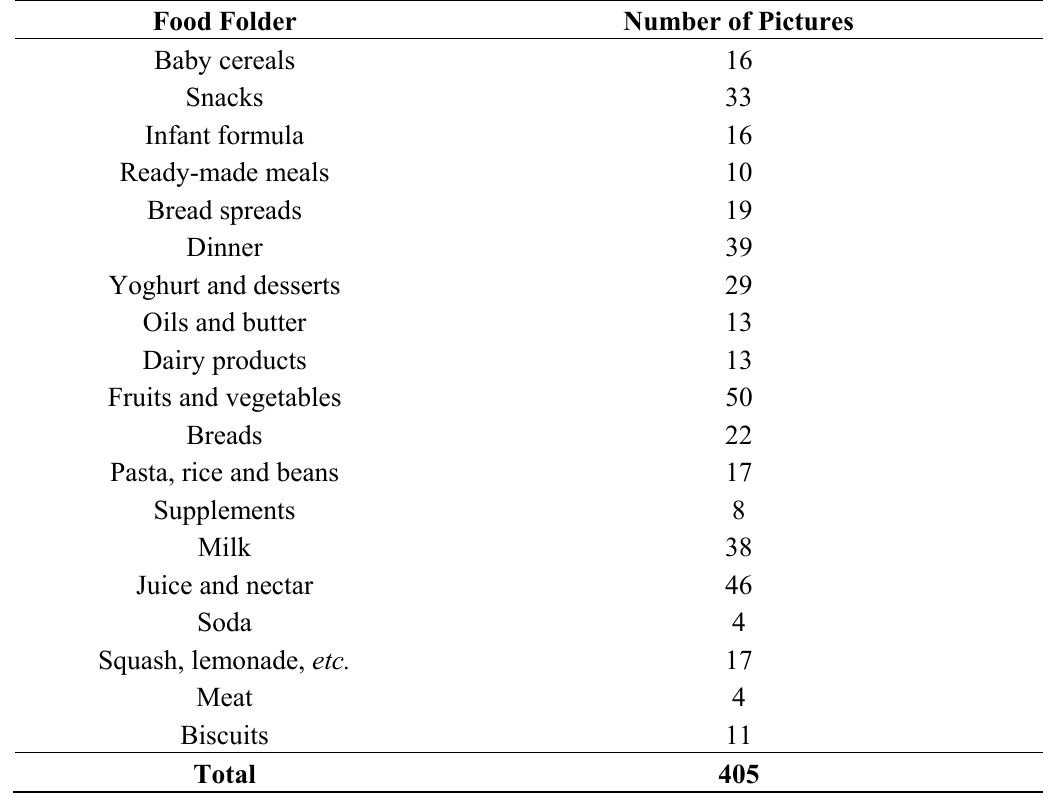
Table 1. Number of pictures in each folder of the picture